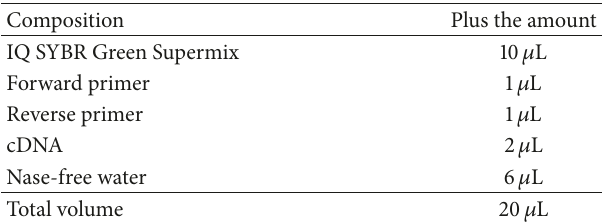
Figure 1: The EC of CGA 1–4.